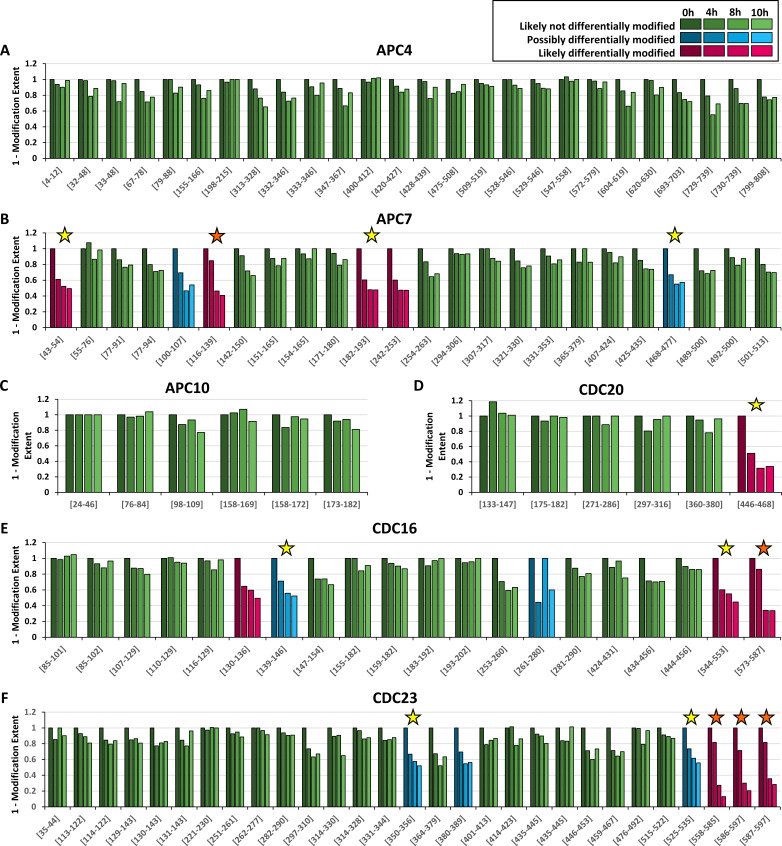
FLEXIQuant-LF analysis of remaining APC/C components analyzed as superprotein.Peptide classification and extent of modification of (A) APC4, (B) APC7, (C) APC10, (D) CDC20, (E) CDC16, (F) CDC23 analyzed with FLEXIQuant-LF. APC15 and APC16 were analyzed using the ‘superprotein’ approach, the remaining proteins were analyzed individually. Green bars indicate peptides that were classified as likely not differentially modified at 10 hr (RM score ≥0.6), blue bars indicate peptides classified as possibly differentially modified (0.5 ≤ RM score<0.6) and magenta bars indicate peptides that classified as likely differentially modified (RM score ≤0.5). For each class, the four time points are shown in different color shades, from time point 0 hr (S phase; darkest shade) to time point 10 hr (brightest shade). Positions of peptides within the protein are given from the N- to C-terminus. Peptides labeled with an orange star indicate that a modification was identified on this peptide in the DDA dataset and peptides labeled with a yellow star indicate a modification that was described in the literature.